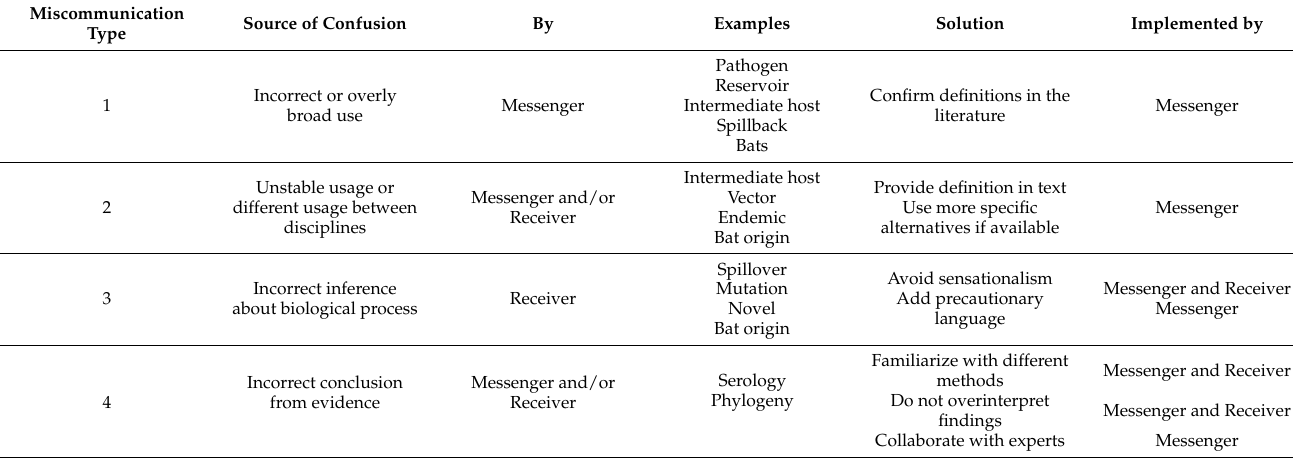
Table 1. Summary of the main types of miscommunication identified. For each type of miscommunication, we identify the main reason that confusion occurs, whether it originated in the messenger, receiver, or both, and offer possible solutions that can be implemented by either the messenger or receiver. We also list all the terms that we define in this paper and use to exemplify each type of miscommunication. Terms are listed within each miscommunication type in the order they appear in the